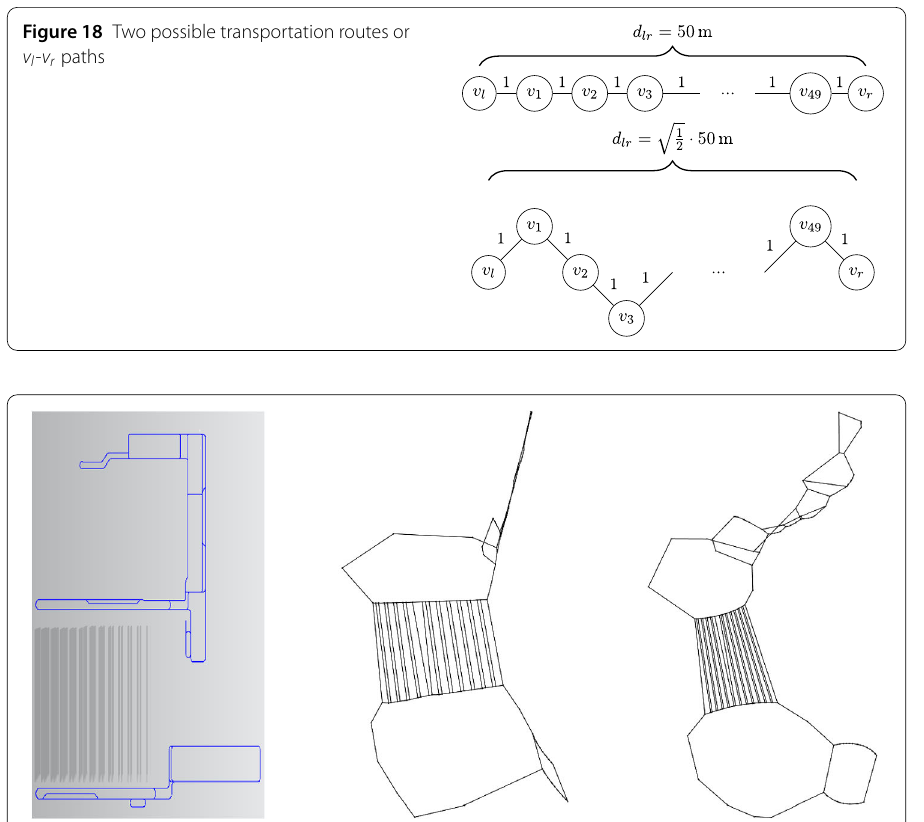
Figure 19 Original, initial and optimal layouts of OCS without reference nodes